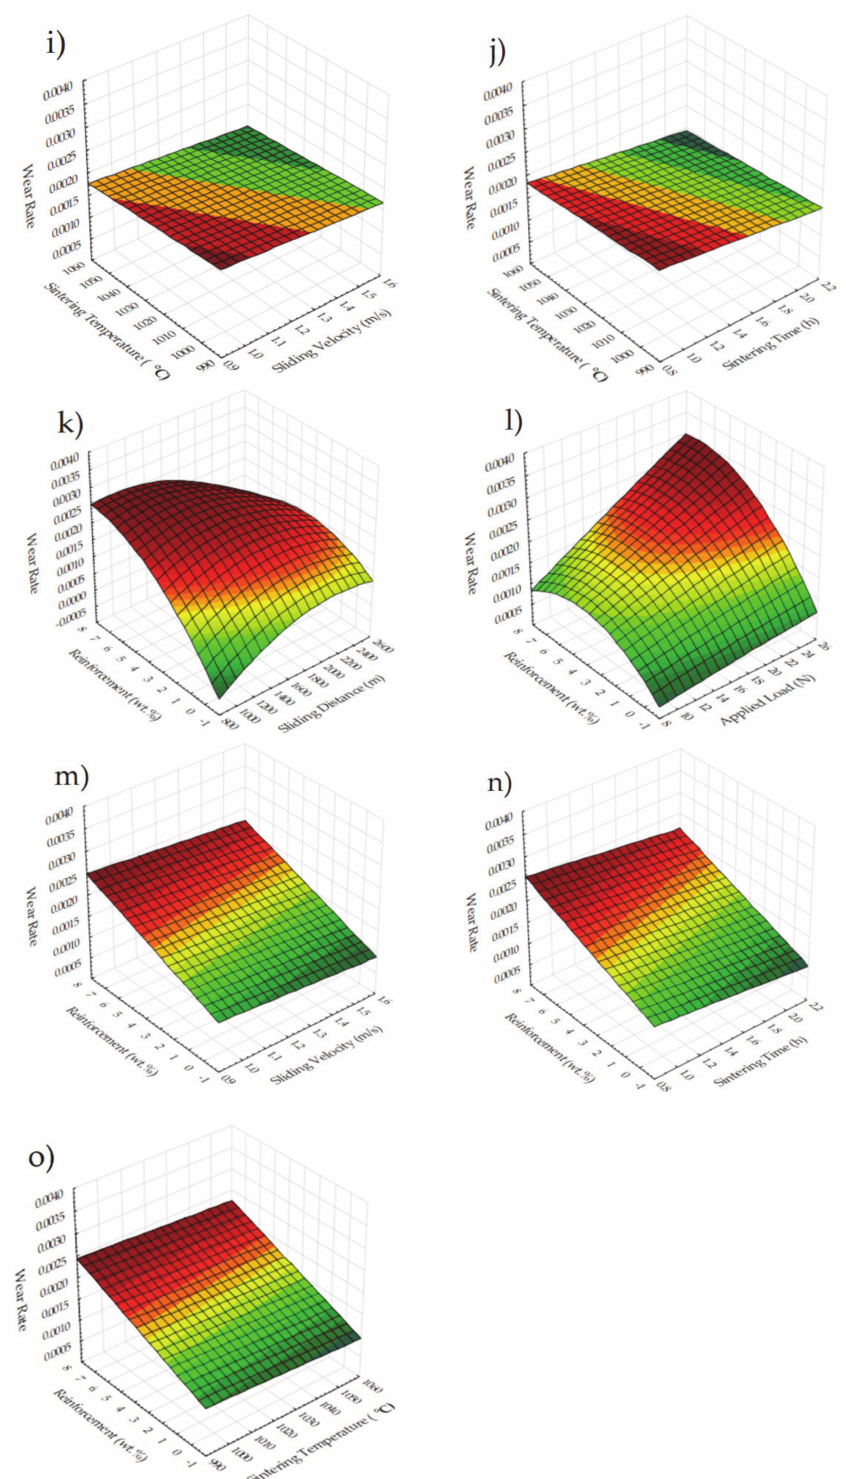
Figure 10. 3D surface plots for wear rate for the effect of ( a ) Sliding distance and applied load ( b ) Sliding velocity and sliding distance ( c ) Sintering time and sliding distance ( d ) Sintering tem- perature and sliding distance ( e ) Sintering temperature and applied load ( f ) Sintering time and applied load ( g ) Sliding velocity and applied load ( h ) Sintering time and sliding velocity ( i ) Sintering temperature and sliding velocity ( j ) Sintering temperature and sintering time ( k ) Reinforcement and sliding distance ( l ) Reinforcement and applied load ( m ) Reinforcement and sliding velocity ( n ) Reinforcement and sintering time ( o ) Reinforcement and sintering